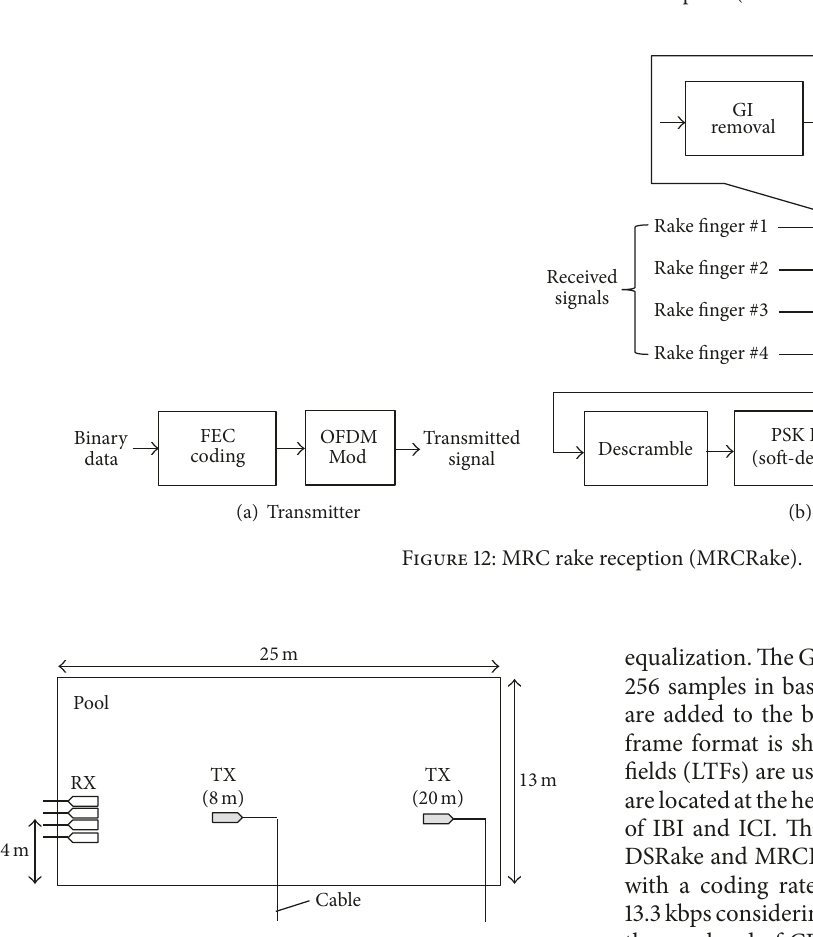
Figure 11: Data selective rake reception (DSRake).